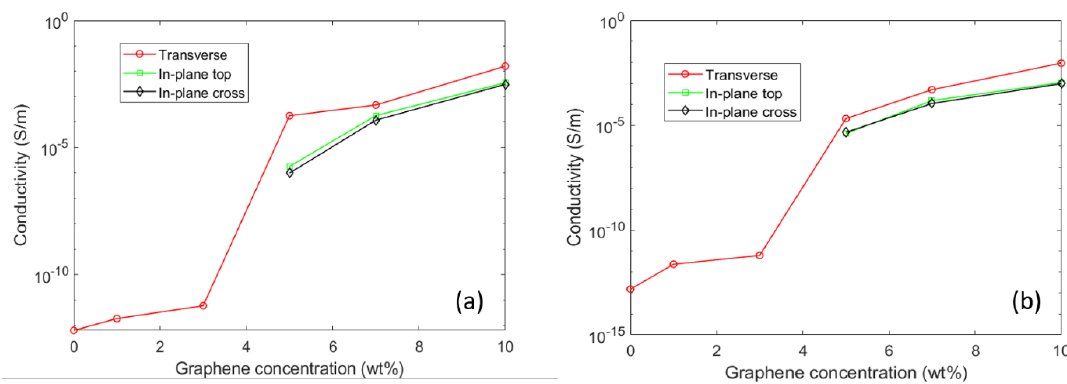
Figure 3. Transverse and in-plane conductivity of ( a ) unfilled and ( b ) GF-reinforced polyester as a function of the graphene concentration. The transverse conductivity was assumed to be the real part of the complex conductivity at 0.1 Hz while the in-plane conductivity was measured by the four-point technique. The latter measurement was conducted both on top of the flat section (top) and on the side section (cross) of the samples, yielding similar results.